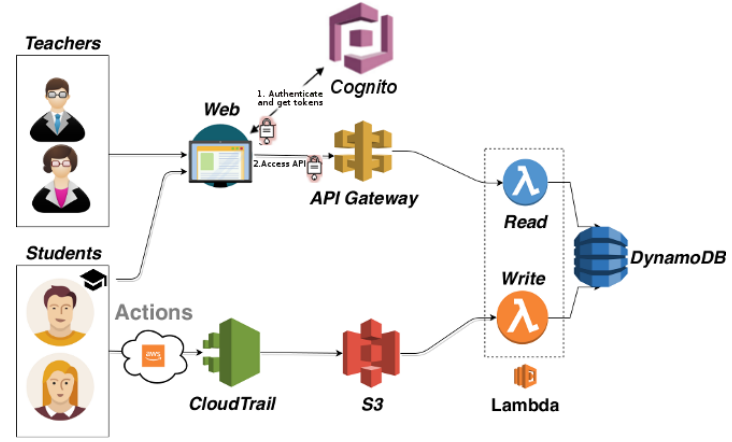
Figure 1. Architecture of